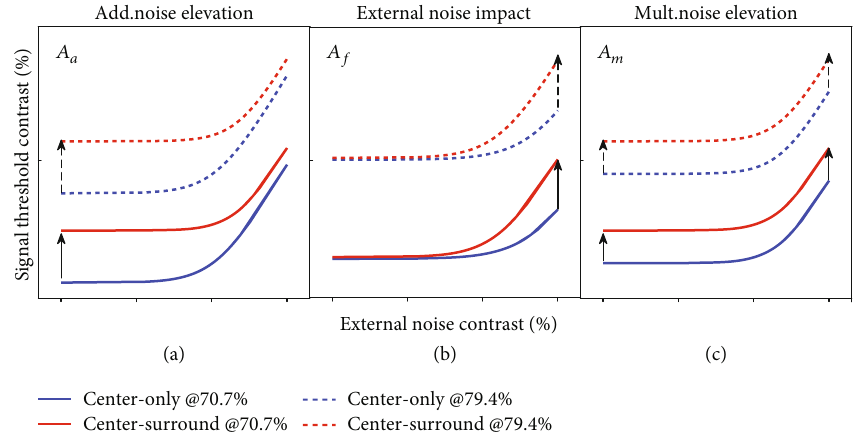
Figure 4: Possible mechanisms of surround suppression e ff ect on neuronal contrast sensitivity predicted by PTM. Each panel shows how TvC curves at two performance criteria would change during surround suppression for changes in one of three PTM parameters where A A A a represents internal additive noise (a), f represents external noise exclusion (b), and m represents multiplicative noise (c). In all three panels, blue curves represent TvCs from the center-only group, whereas red curves represent TvCs from the center-surround group. Solid lines represent less stringent performance criteria (70.7%); dotted lines represent more stringent performance criteria (79.4%). Arrows represent the hypothetical size and direction of change in performance a ff ected by surround